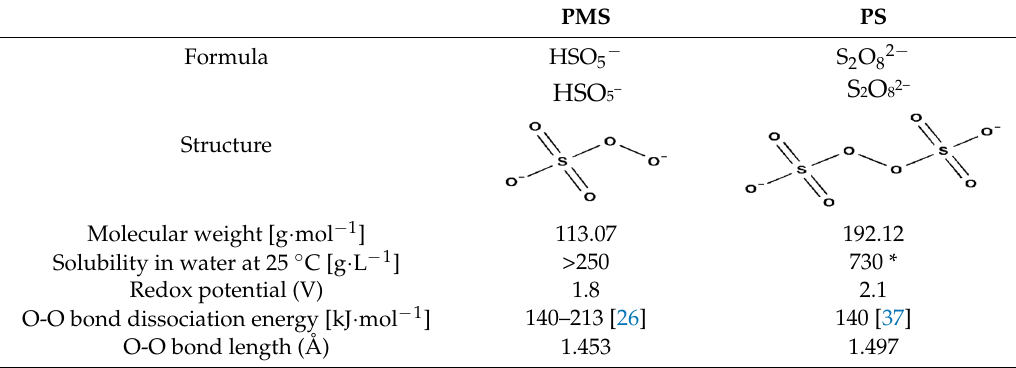
Table 2. Chemical properties of peroxymonosulfate (PMS) and persulfate (PS).